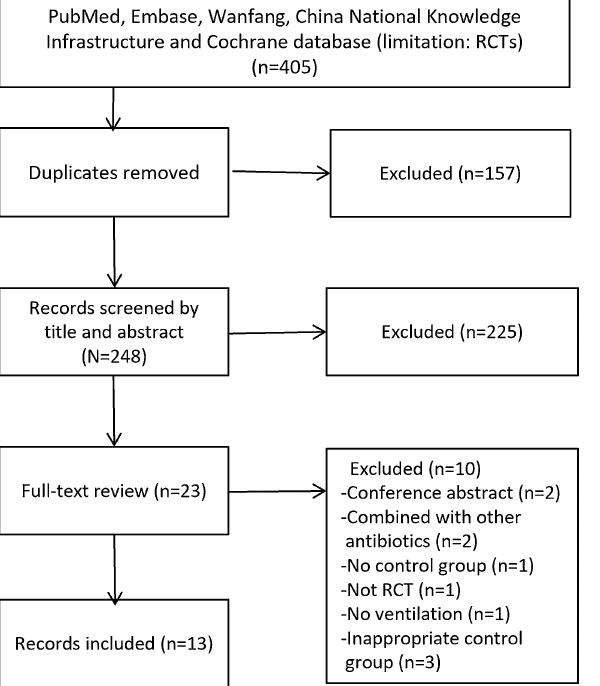
Figure 1. Selection process for RCTs included in the